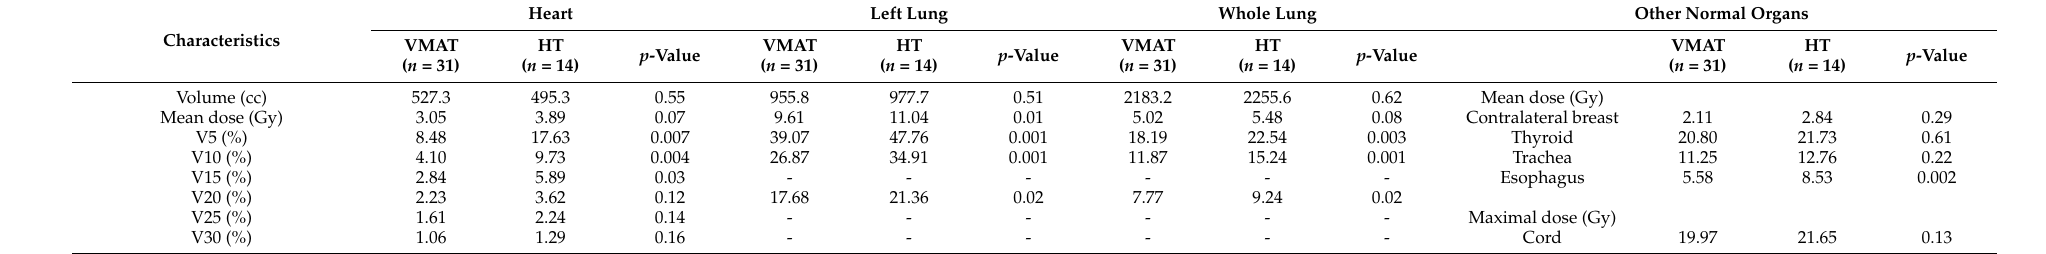
Table 4. Comparison of RT treatment factors and dosimetry parameters between VMAT and HT in patient subgroup of RNI without